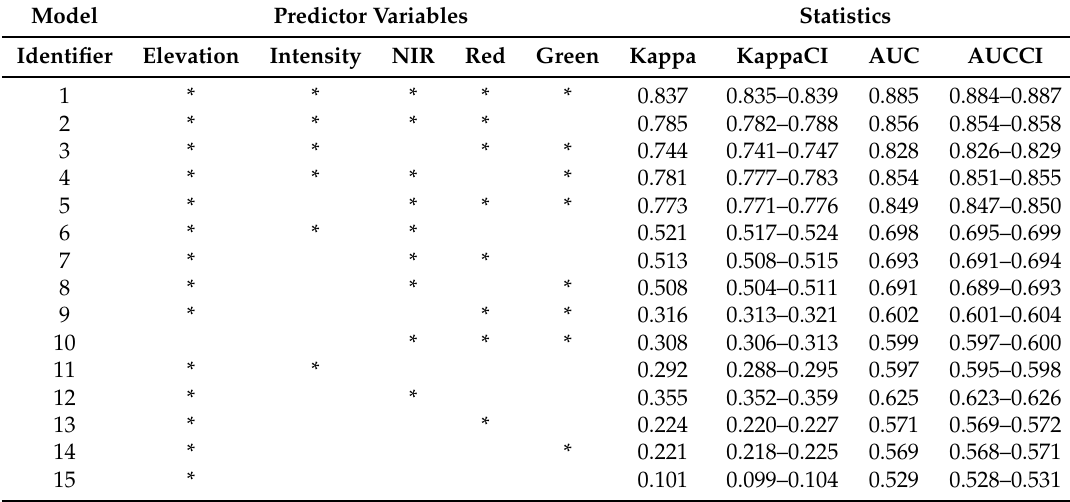
Table 5. Classification accuracy expressed through Cohen’s Kappa and associated 95% confidence interval (KappaCI), area under curve (AUC) and the associated 95% confidence interval (AUCCI) from receiver operator characteristic (ROC) curves for all 15 models examined. Predictor variables denoted with an * were included in the